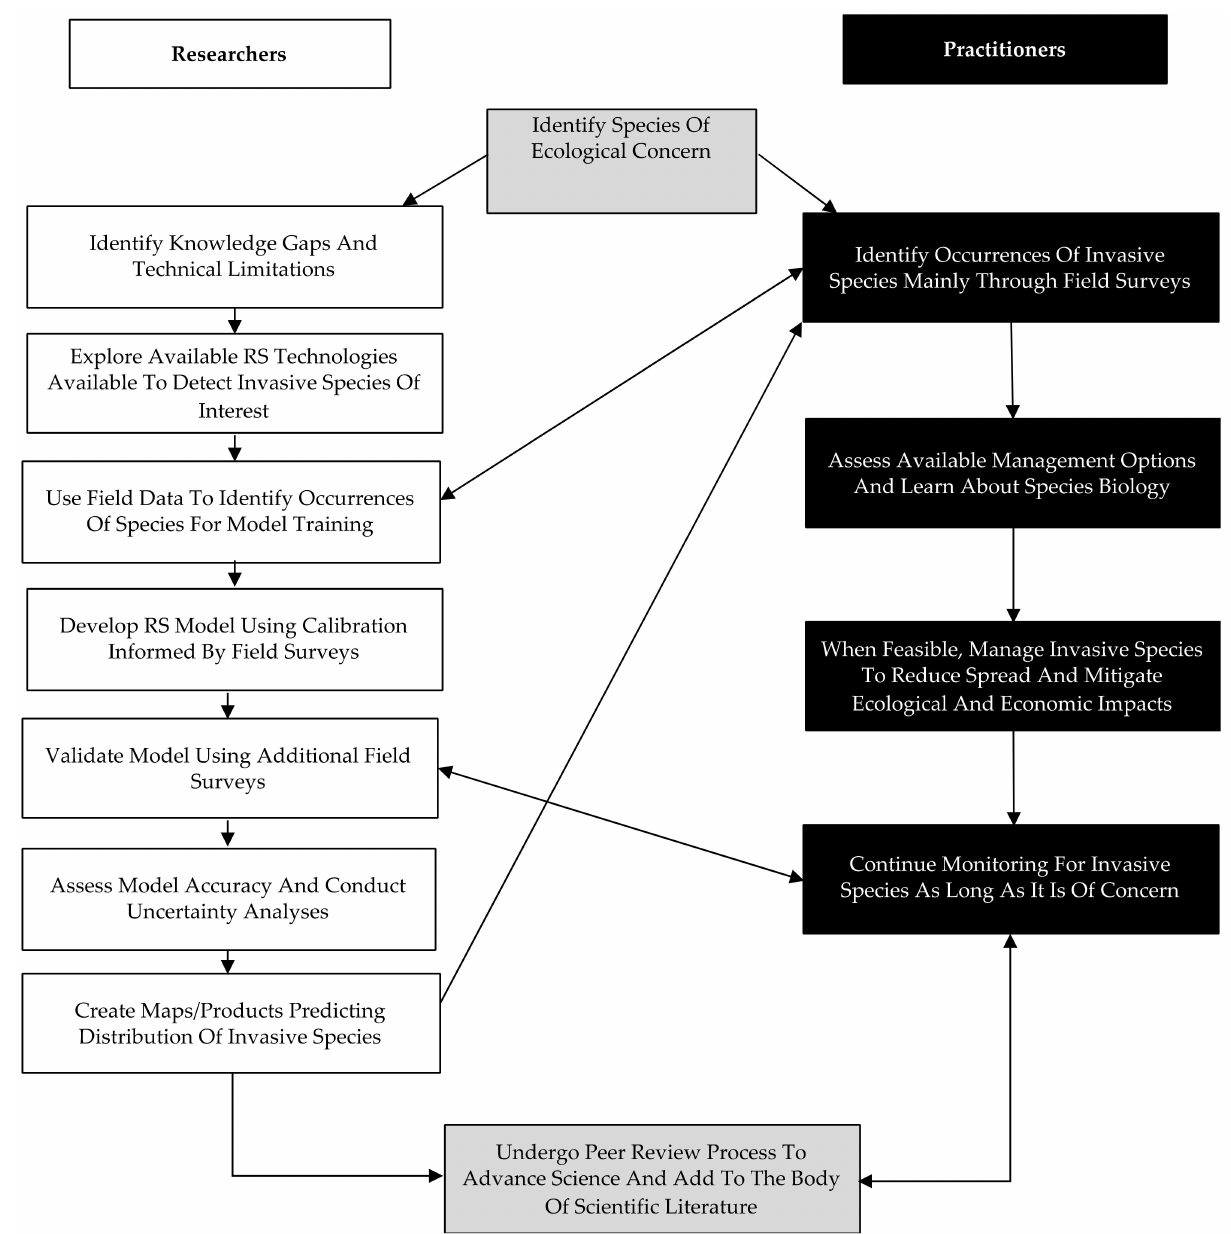
Figure 1. Simplified workflow used by RS researchers to map invasive species and their impacts ( left ) and practitioner’s workflow to locate and manage invasive species ( right ). Double sided arrows indicate steps in each group’s workflow where researcher–practitioner collaboration could effectively advance the objectives of both